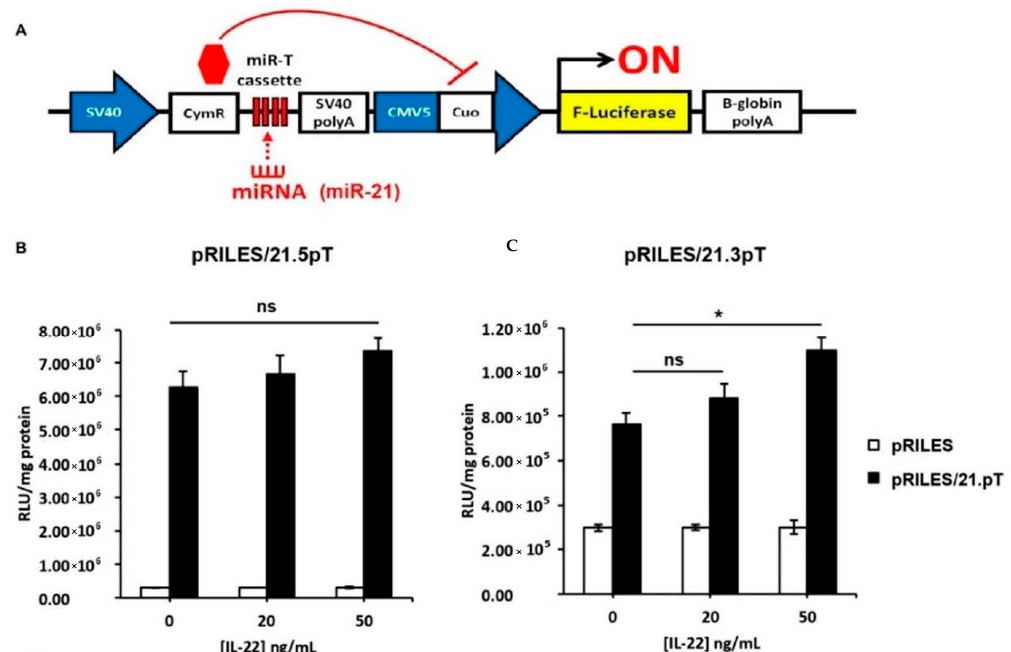
Figure 5. Functional assay using the RNAi-inducible luciferase expression system (RILES) to monitor miR-21 activity in HaCaT cells. ( A ) Schematic representation of the RILES construction. Briefly, the firefly luciferase reporter gene is repressed by a translational repressor (CymR—in red). The latter is under the control of the miR-21 cassette (miR-21.5pT or miR-21.3pT cassette, black histogram). Thus, the binding of miR-21-5p or miR-21-3p to the miR-21.5pT and miR-21.3pT cassette, respectively, results in CymR degradation that is translated by luciferase expression. Changes in luciferase levels reflect whether or not a miRNA can induce CymR mRNA degradation or translation arrest, which indicate miRNA functionality. An empty miR cassette, pRILES, was used as a control plasmid. ( B , C ) miR-21-5p and miR-21-3p expression induction assessments using RILES technology in HaCaT cells stimulated with 0, 20, 50, and 100 ng/mL of IL-22 for 24 h. Data are presented as relative luciferase units (RLU) normalized to the total amount of protein (mg). Data information: results are presented as mean values ± SEM. Data are representative of three independent experiments performed in triplicate. The statistical comparison between groups was performed by using two-tailed Student’s t -test: * p <